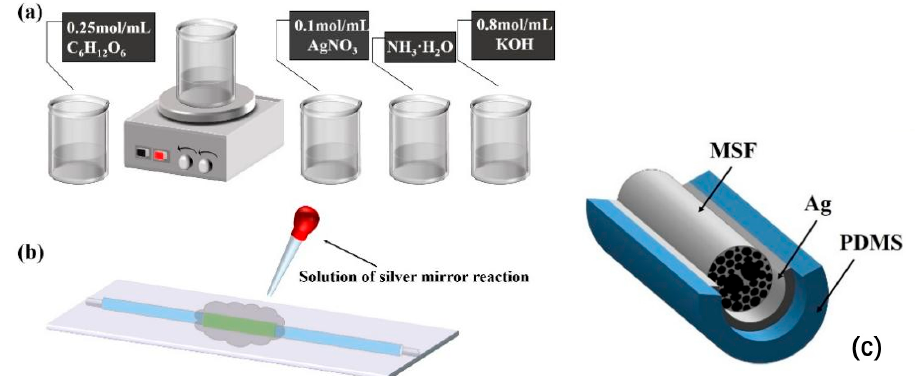
Figure 3. ( a ) Configuration process of silver ammonium complex; ( b ) coating the MSF with Ag thin layer; ( c ) the three-dimensional structure of the MSF coated with silver film and PDMS. The reaction solution was dropped on the sensing part in an extremely short